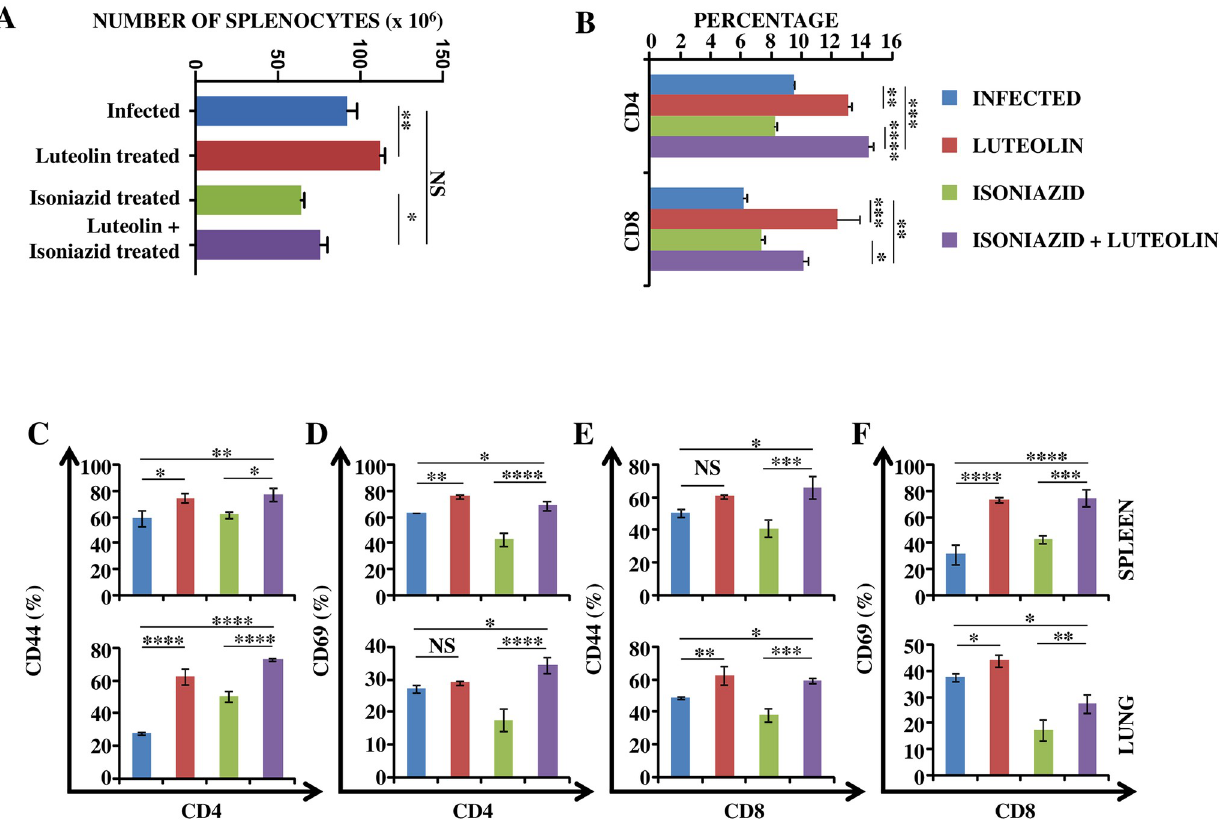
Fig 2. Luteolin induces protective T cell responses. T lymphocytes isolated from lungs and spleens of the indicated groups of experimental mice at 60 days post-infection were surface-stained with anti-CD4, -CD44 and -CD69 antibodies on ice and fixed prior to acquisition by flow cytometry. (A) Number of splenocytes in Infected, Luteolin-treated, Isoniazid-treated and Luteolin+Isoniazid-treated mice. (B) Percentage of CD4 + and CD8 + T cells in splenocytes of Infected, Luteolin-treated, Isoniazid-treated and Luteolin+ Isoniazid-treated mice. CD4 + T cell activation shown by CD44 (C) and CD69 (D) in spleen (upper panel) and lung (lower panel) of mice infected with H37Rv and treated with Luteolin, INH or Luteolin+INH. CD8 + T cell activation shown by CD44 (E) and CD69 (F) in spleen (upper panel) and lung (lower panel) of mice infected with H37Rv and treated with Luteolin, INH or Luteolin+INH. Data shown are representative of three independent experiments with three mice in each group and represent the MEAN ± STDEV values. Differences were considered significant at P < 0.05 and are represented by � p < 0.05, �� p < 0.01, ��� p < 0.001, ���� p < 0.0001 whereas non-significant differences are denoted by